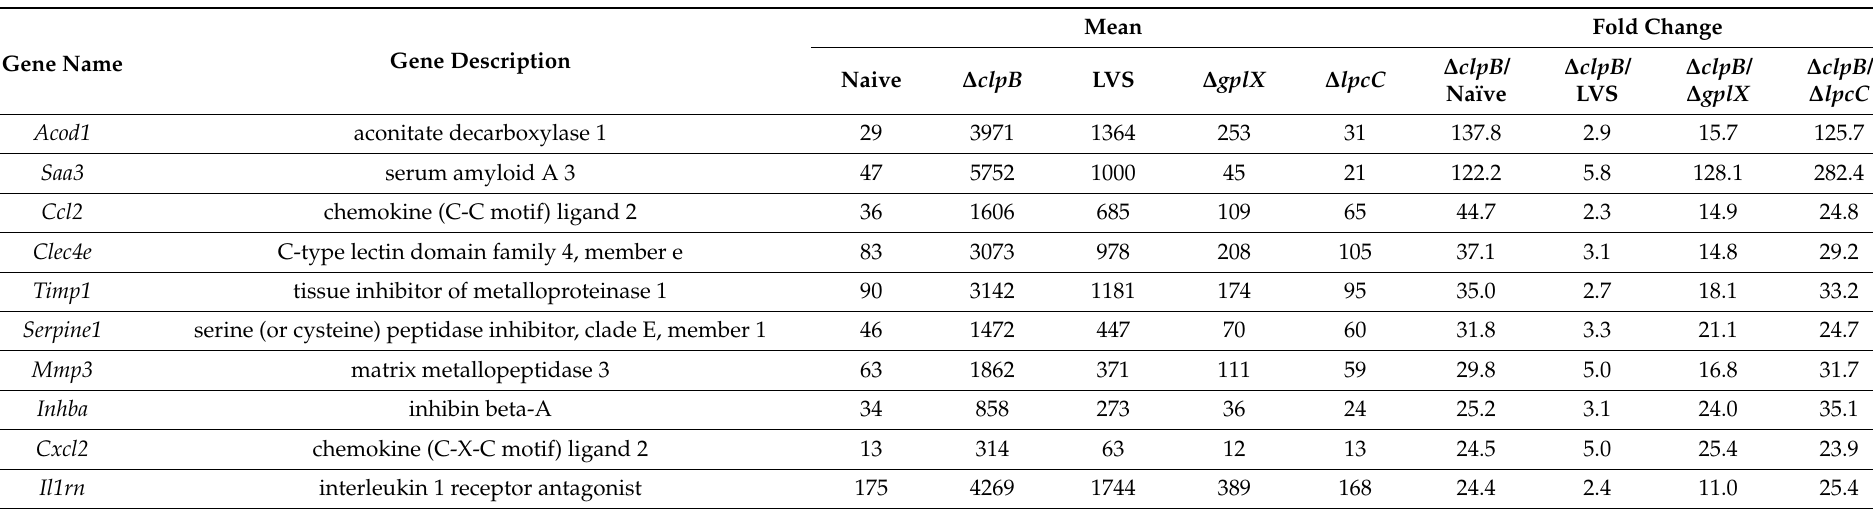
Table 5. Selected biomarkers and their relative expressions and fold changes vs spleens from naïve